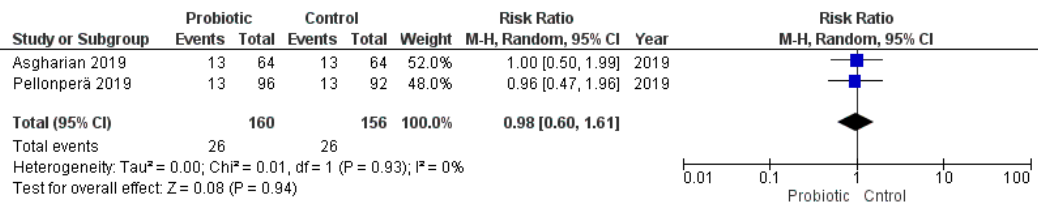
Figure 8. Meta-analysis of studies evaluating the administration of probiotic and macrosomia.